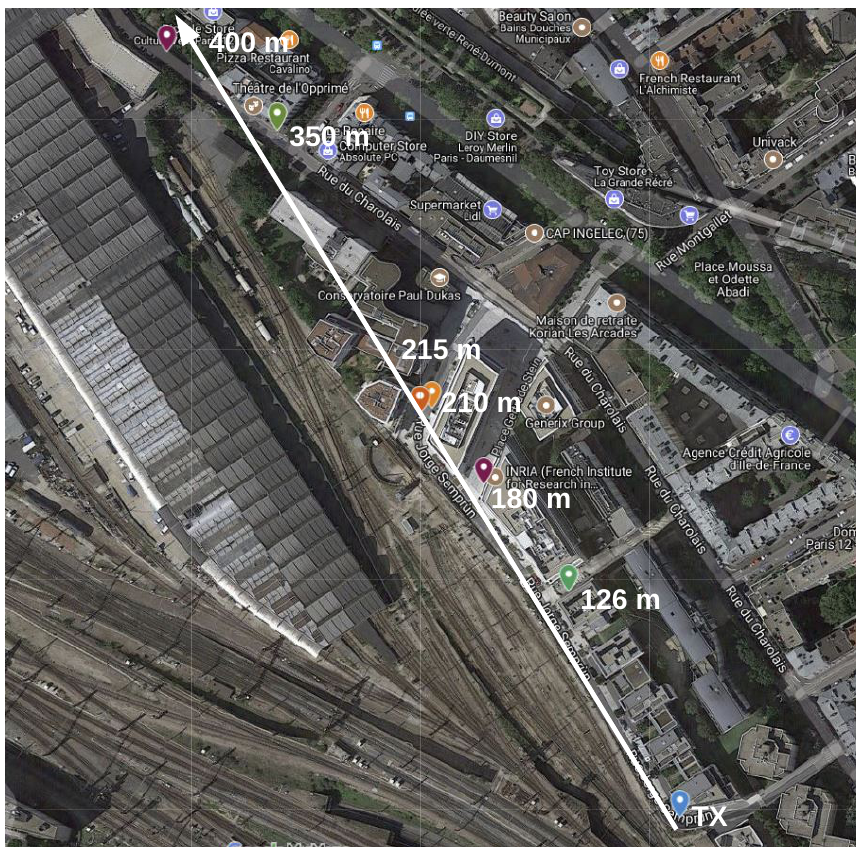
Figure 6. Advance Metering Infrastructure